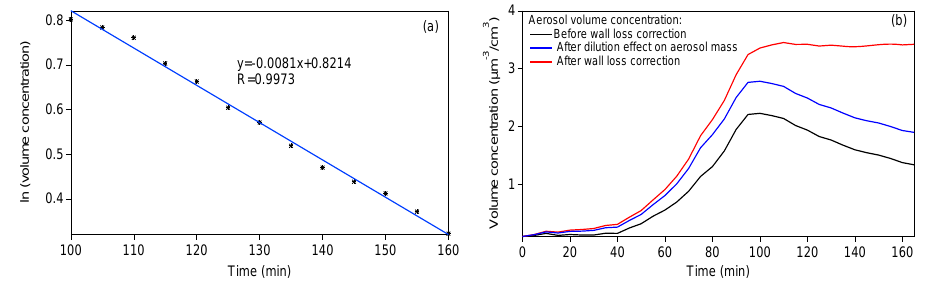
Fig. 1. (a) Logarithm of measured volume concentration as a function of time in smog chamber in experiment P1023. Aerosol wall loss rate was obtained from the fitting Eq. (3). (b) Aerosol volume concentration after taking account into aerosol depositions on the chamber wall and dilution effects. Black curve is the directly measured aerosol volume concentration as a function of time in smog chamber. Blue curve is for the aerosol volume concentration after taking into account dilution effects arising from the ozone addition at 40 L min -1 for 75 min. Red curve shows the corrected volume concentration by applying the wall loss factor derived in Fig 1a.